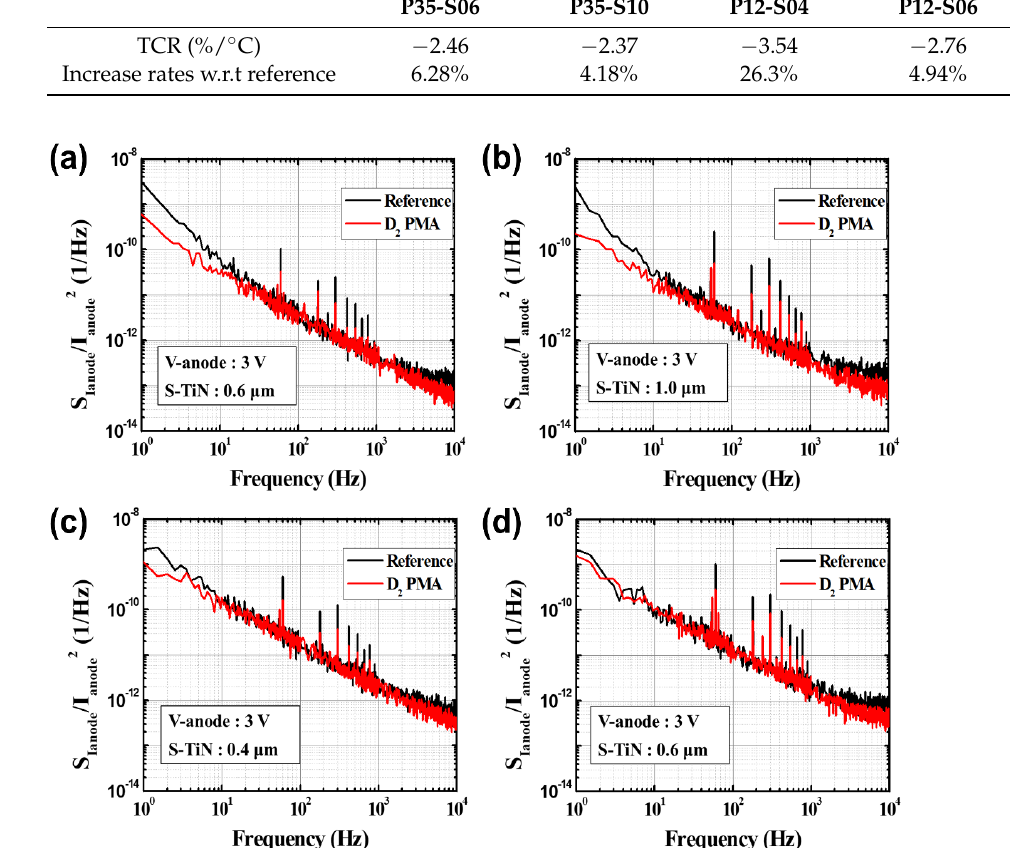
Figure 12. Comparison of noise characteristics normalized with I anodes of the four types of a-Si microbolometers before (black solid lines) and after (red solid lines) applying the PMA process: ( a ) P35-S06, ( b ) P35-S10, ( c ) P12-S04, and ( d ) P12-S06.